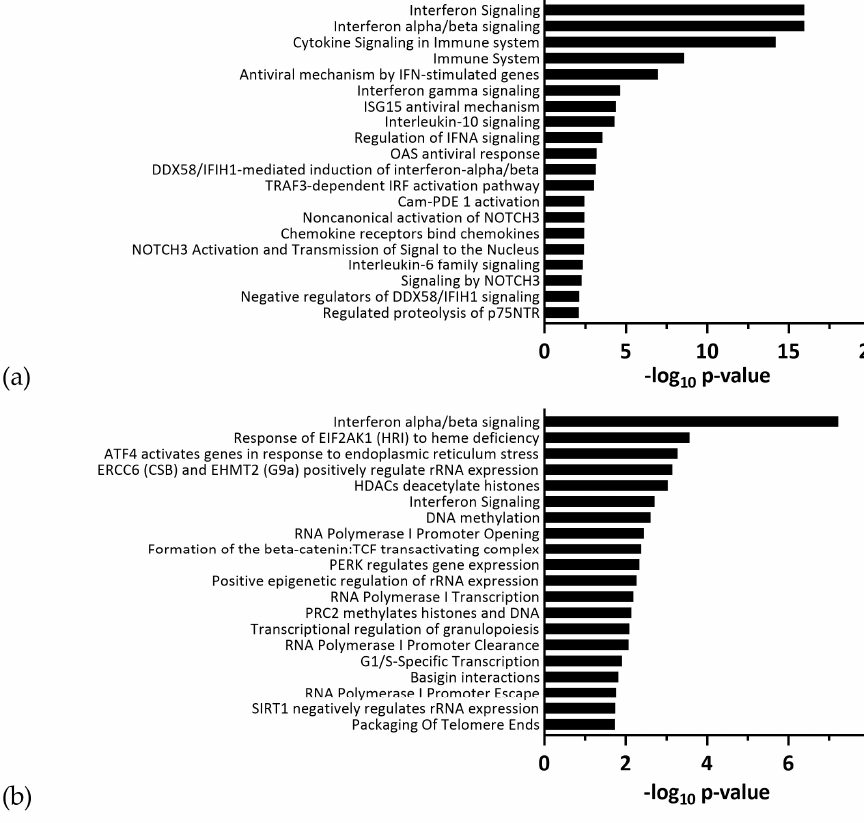
Figure 3. Top 20 enriched pathways identified by functional reactome analysis. Pathway analysis of ≥ two-fold up- and downregulated genes upon infection with either ( a ) ZIKV Polynesia or ( b ) ZIKV Uganda. Pathways ranked according to − log 10 p -value.